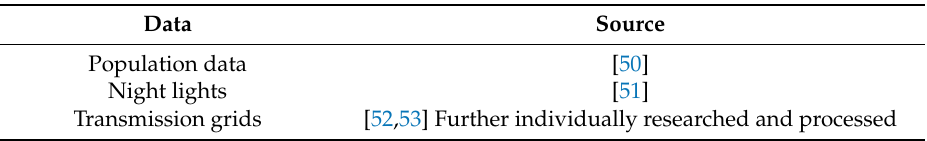
Table 1. Datasets used for analysing the geospatially resolved electrification